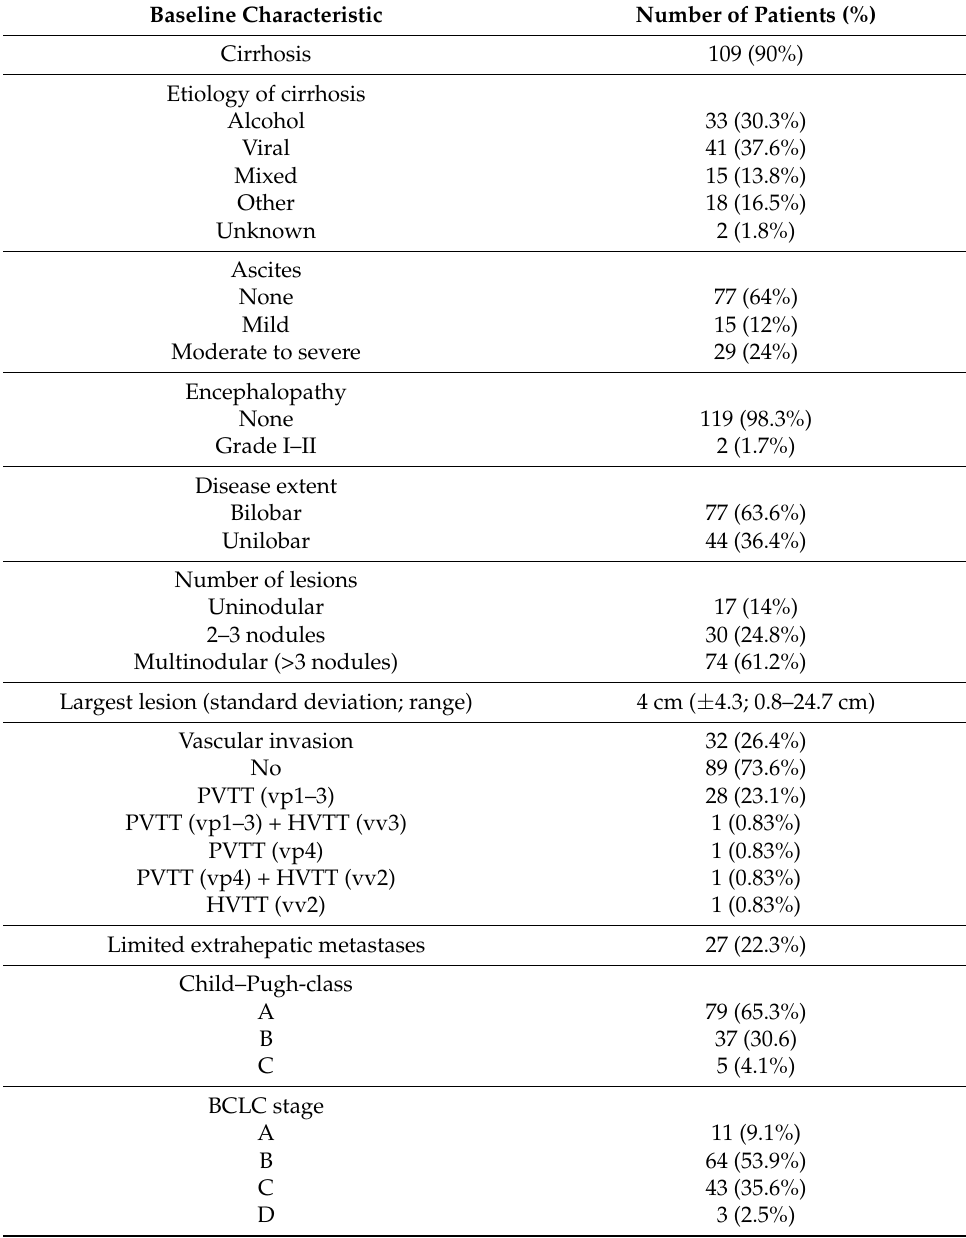
Table 1. Patient baseline